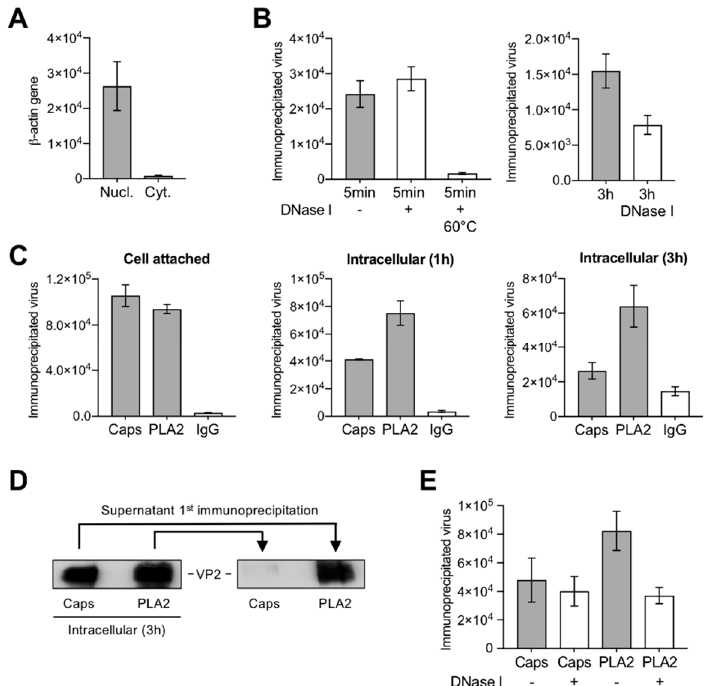
Figure 4. Capsid structural rearrangements and viral DNA externalization in the cytoplasm. ( A ) The purity of the cytoplasmic fraction and the absence of nuclear contamination were examined by quantitative detection of β -actin gene sequences. Values represent DNA copies per microliter. ( B ) Nuclease sensitivity of virions at 5 min and 3 h pi Virus treated at 60 °C for 5 min was used as control. ( C ) Accessibility of VP1u (PLA2 antibody) and VP2 conformational (Caps antibody) epitopes from membrane-bound or intracellular B19V. Virions were immunoprecipitated and quantified by qPCR. As control, an unrelated IgG was used. ( D ) Western blot of B19V immunoprecipitated at 3 h pi. The supernatants were used for a second immunoprecipitation with the indicated antibodies. ( E ) Nuclease sensitivity of B19V immunoprecipitated with the conformational antibody (Caps) or with the VP1u antibody (PLA2) at 1 h pi. All immunoprecipitation values represent geq/µL.